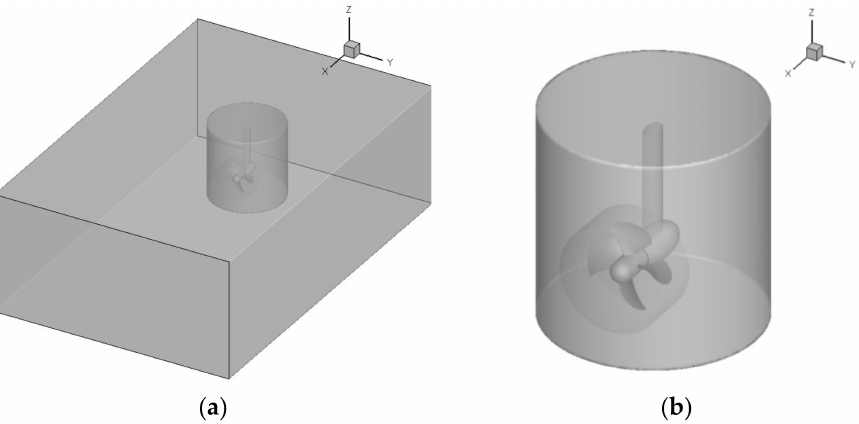
Figure 4. Regional definition of the model: ( a ) Full rotation domain ( b ) cylindrical rotation